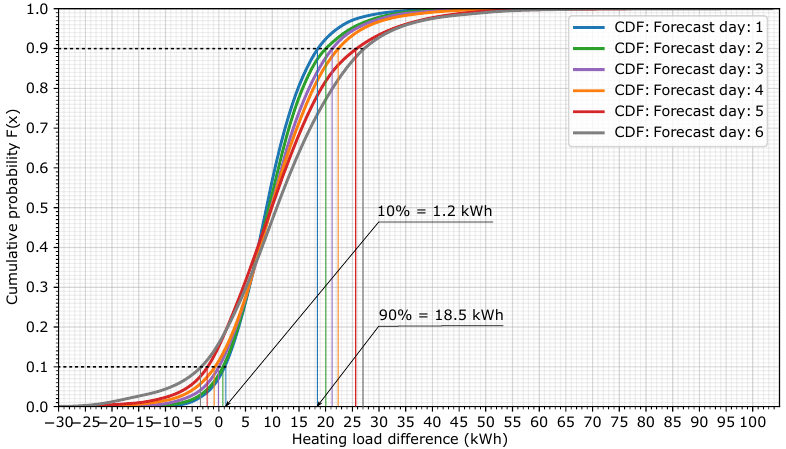
Figure 7. Cumulative distribution function (CDF) for the 6 forecast